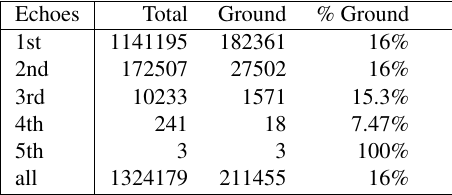
Figure 9: LiDAR echoes